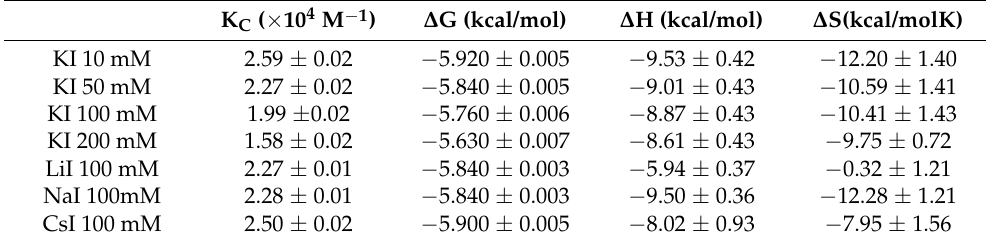
Table 2. The complexation coefficient and the thermodynamic parameters ∆ H, ∆ G and ∆ S for the β -cyclodextrin-phenolphthalein complex formation in the presence of salts. ∆ G was calculated at 20 ◦ C for different KI concentrations and